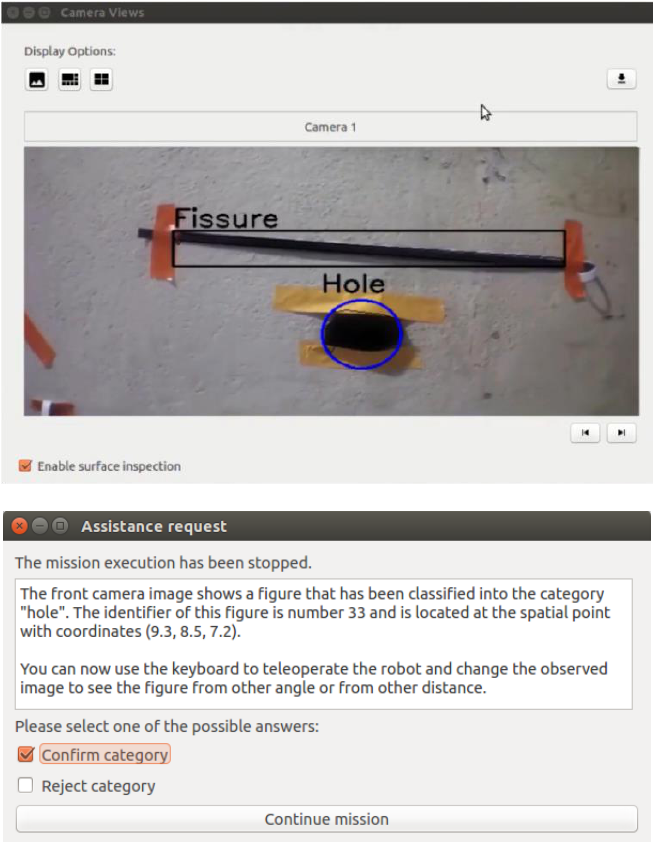
Figure 11. Example of windows to request confirmation of a recognized figure.